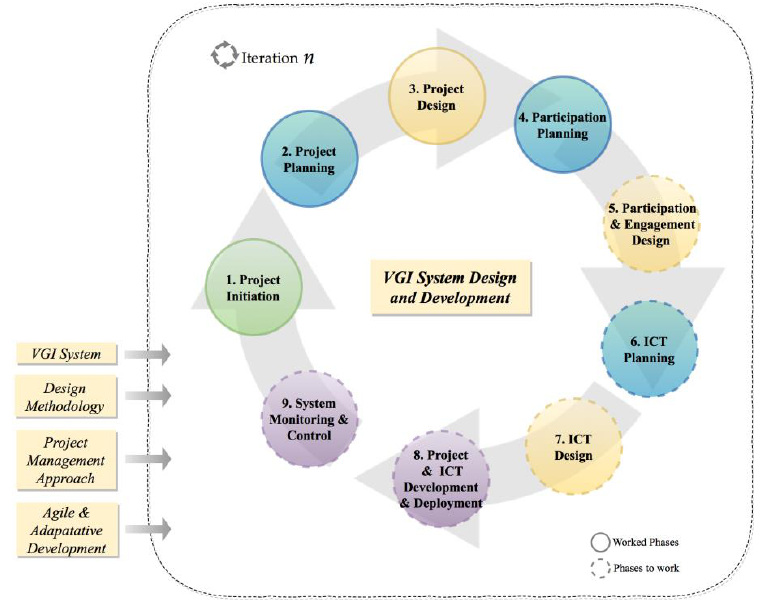
Figure 2. VGI System Design and Development Process, and its Phases.